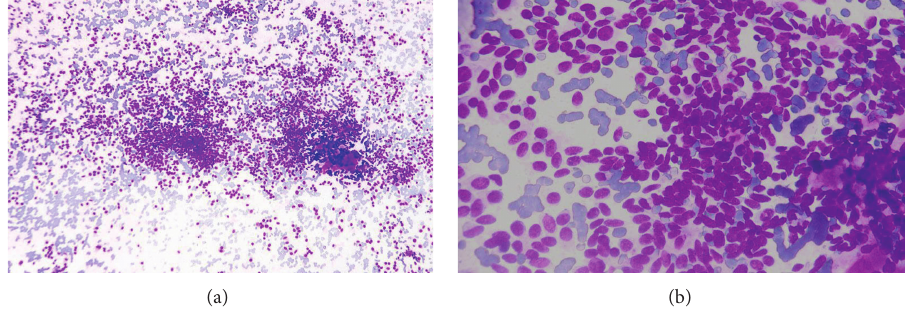
Figure 2: (a) Singly scattered cellular aspirate with cells of variable sizes and shapes on fine needle aspiration [MGG × 100]. (b) Higher magnification exhibiting predominantly oval and spindloid to plasmacytoid cells on fine needle aspiration [H & E